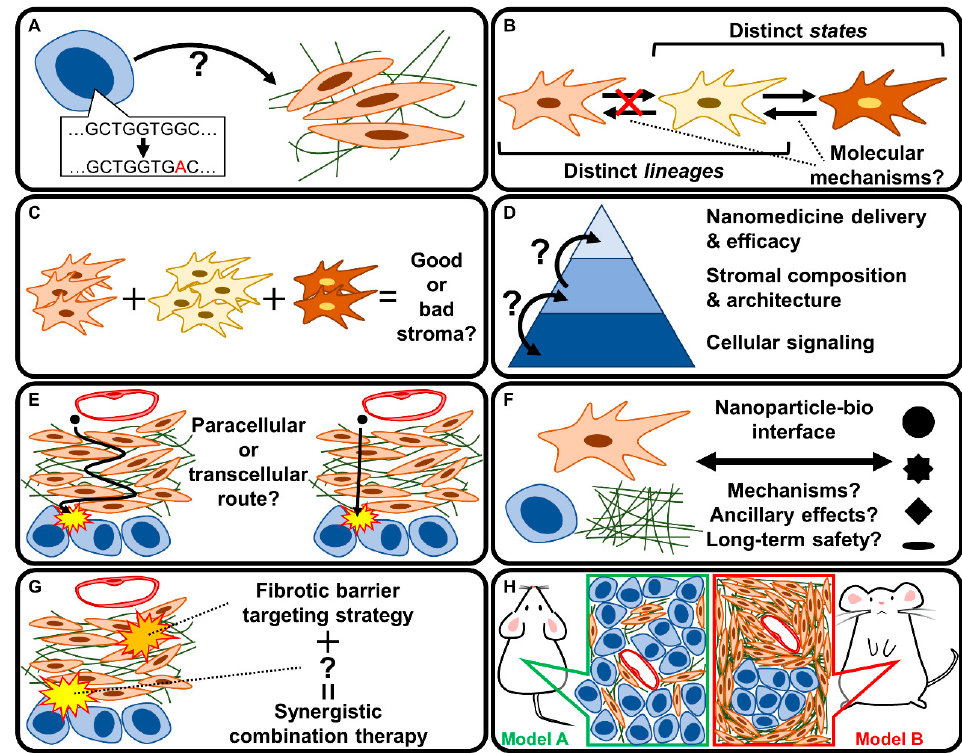
Figure 12. Key unknowns and future directions. ( A ) How does the genotype of the PDAC cancer cell affect fibrosis? ( B ) Are CAF subpopulations interconvertible, and what determines interconvert-